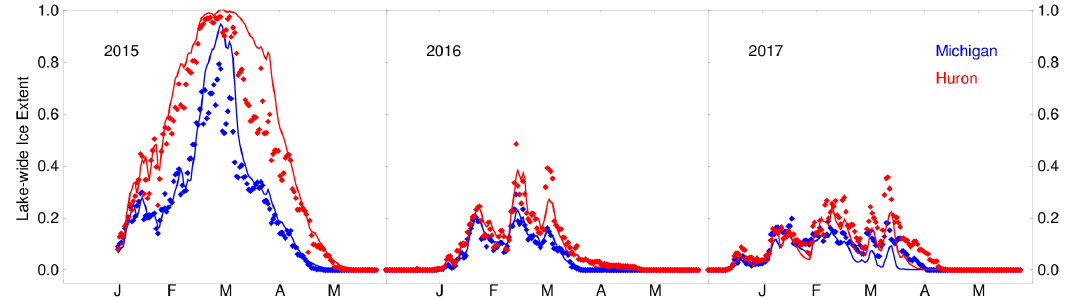
Figure 6. Lake-wide average ice extent for Lake Michigan ( blue ) and Lake Huron ( red ). The model ice extent (solid lines) is compared to the NIC (diamonds).